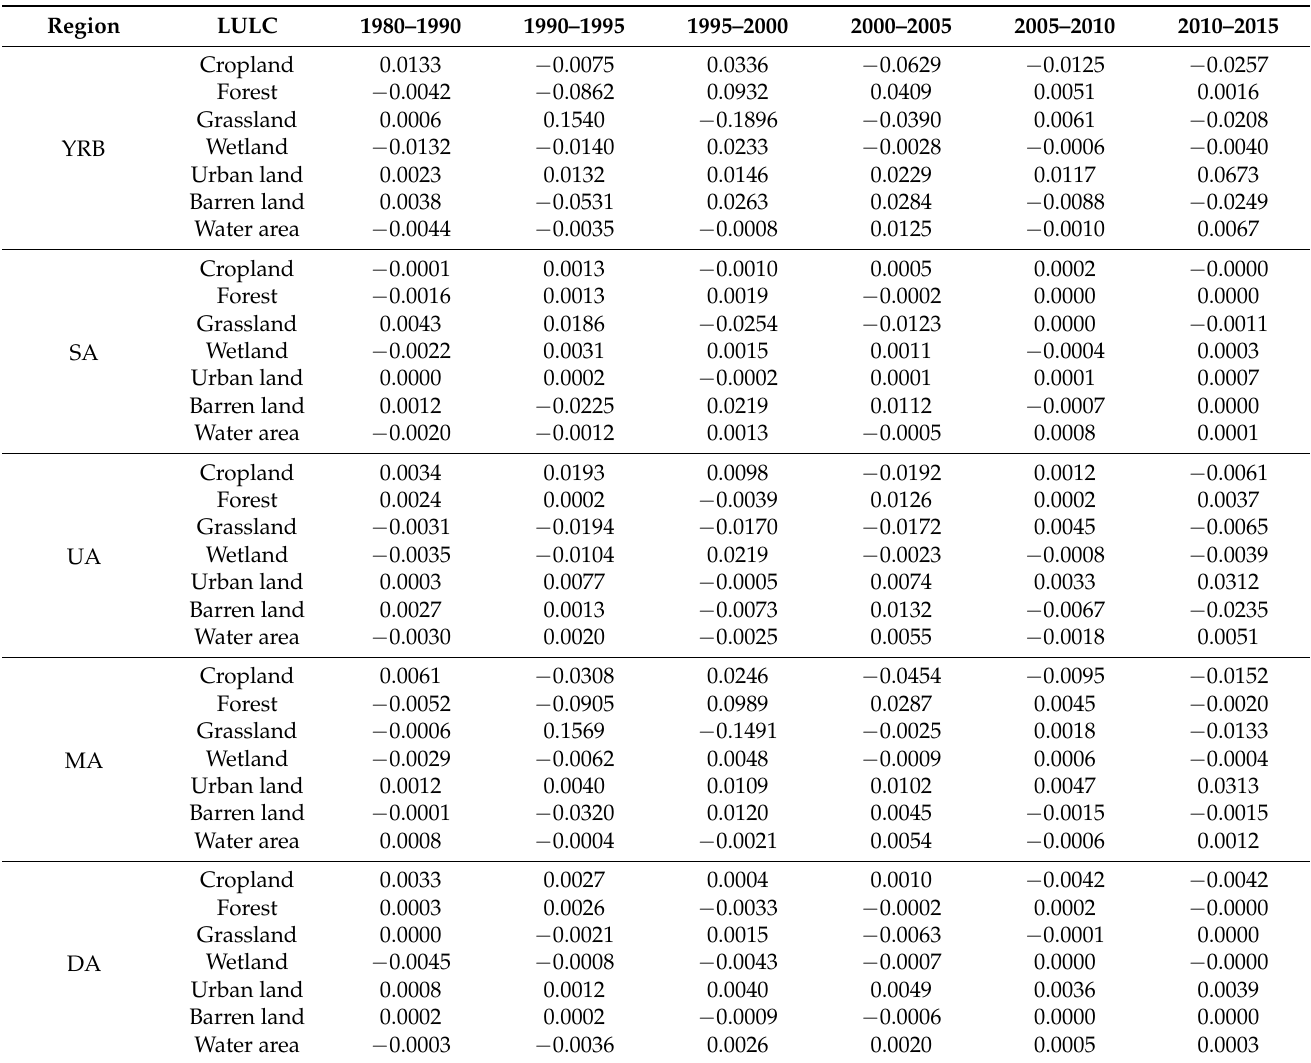
Table A3. LULC change rate (Mha/a) in different